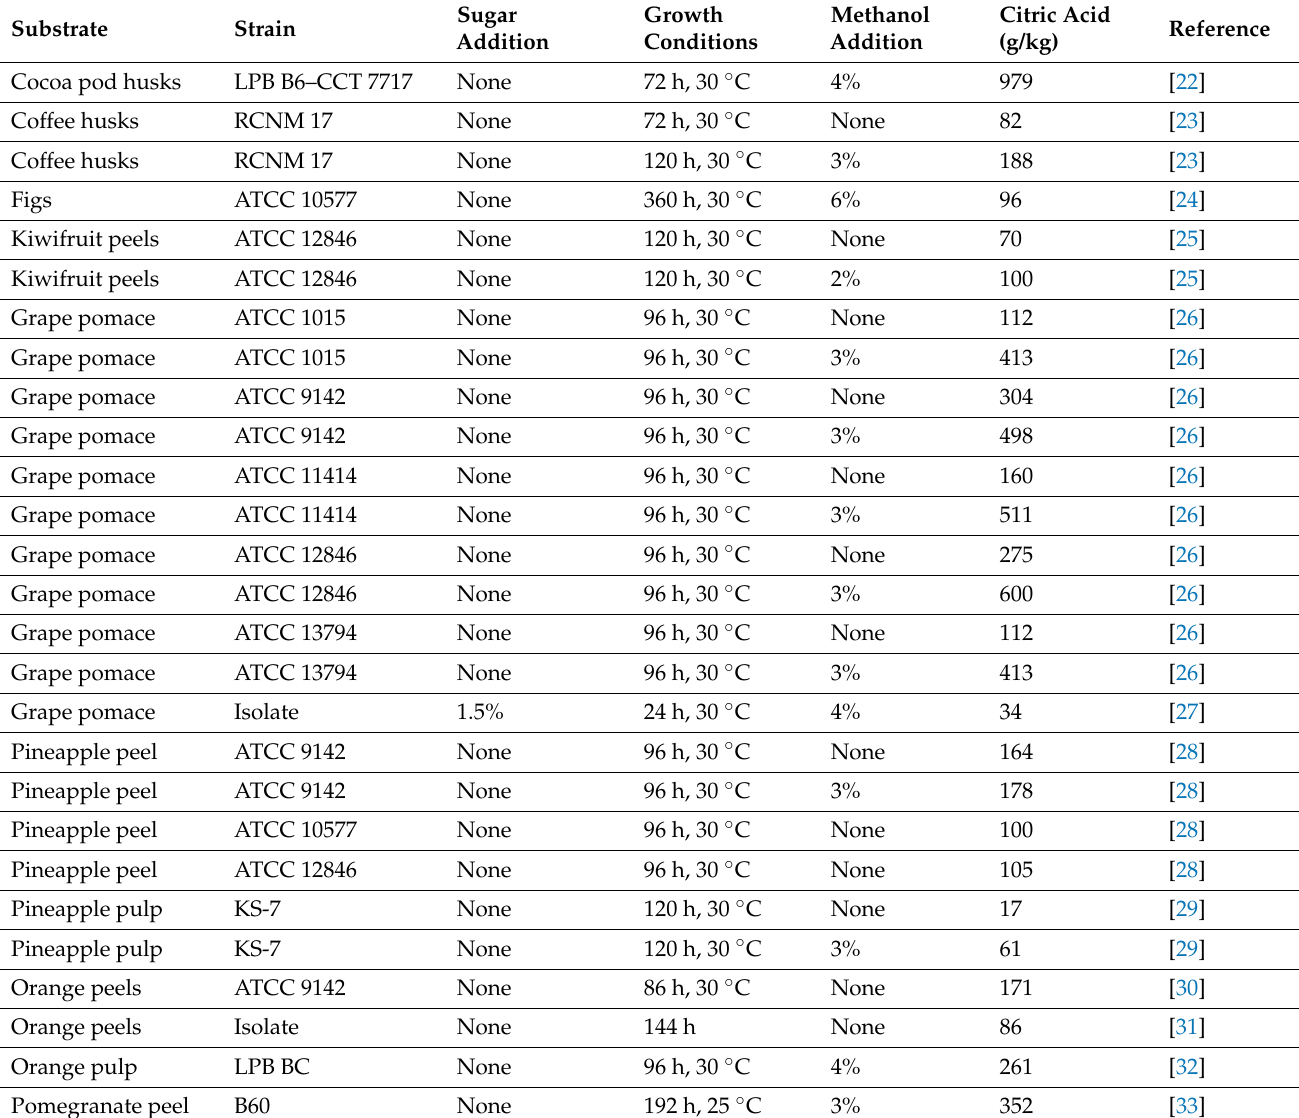
Table 2. Growth conditions and maximum citric acid production by Aspergillus niger strains on processing wastes of cocoa pods, coffee husks, figs, kiwifruit, grapes, pineapples, oranges and pomegranates using solid-state